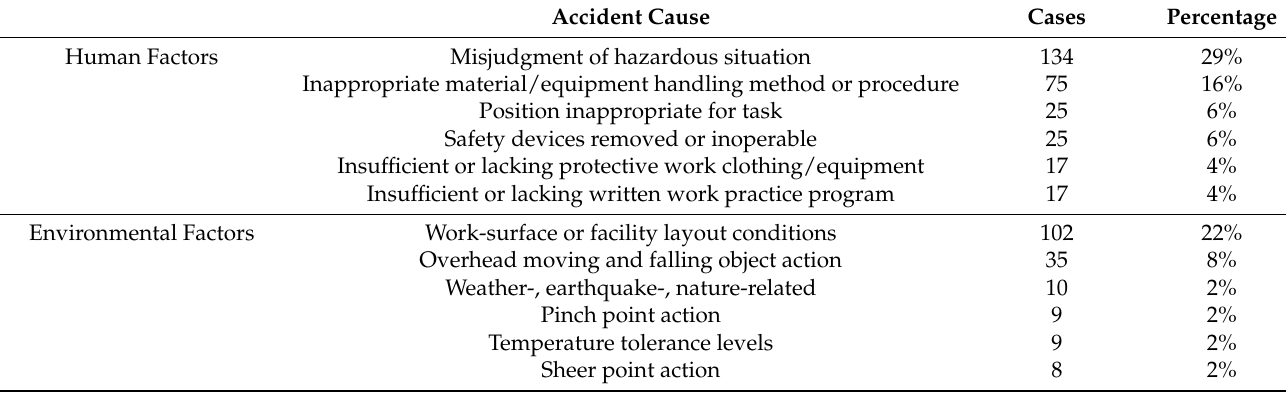
Table 1. Prominent accident causation factors in construction based on data analysis.